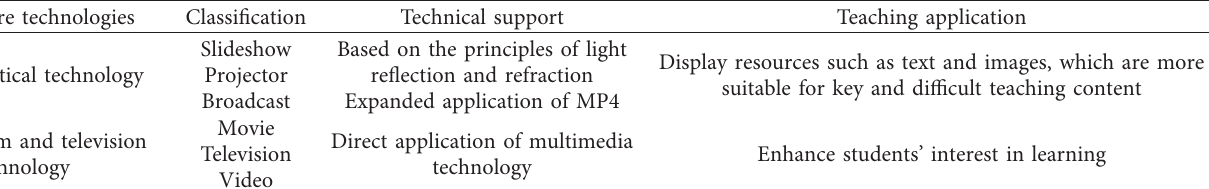
Table 1: Multimedia courseware technology in the